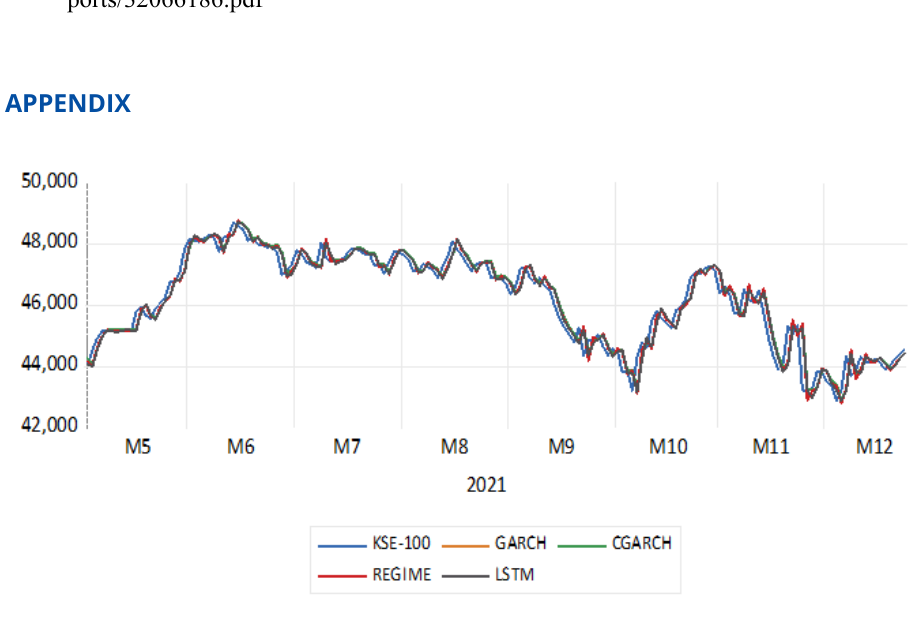
Figure A. 1: Forecast performance comparison